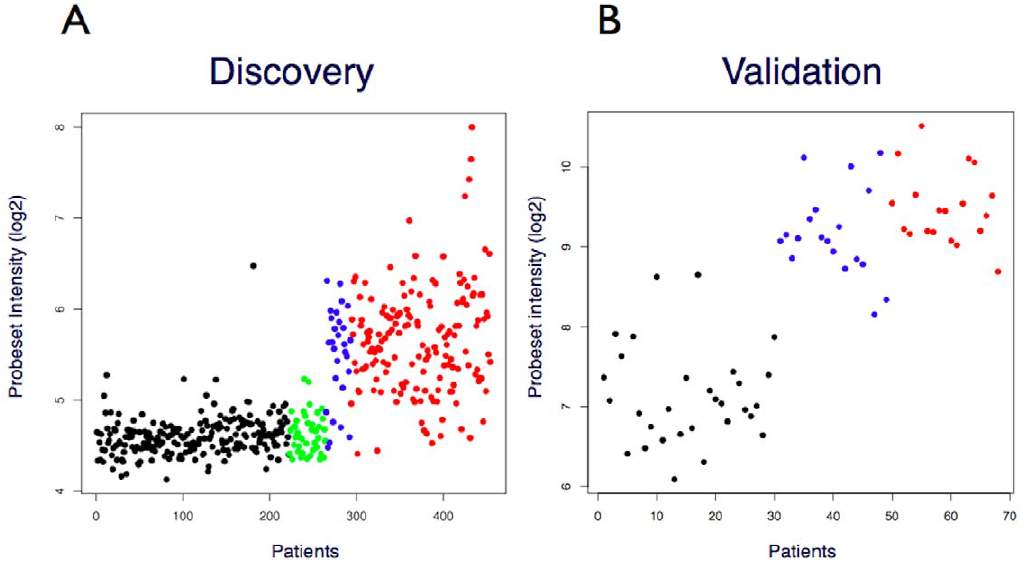
Figure 2. NFE2L3 – prototypical ‘switched ON’ gene in colorectal neoplastic tissue relative to non-neoplastic tissue specimens. (A) Discovery data set, 222 normal, black; 42 IBDs, green; 29 adenomas, blue; 161 adenocarcinomas, red. (B) Validation data set: 30 normal, black; 19 adenomas, blue; 19 adenocarcinomas, red. Y-axis: Normalized probeset intensity (log2).